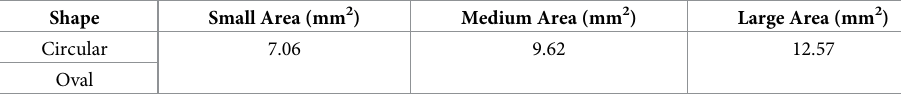
Table 1. Areas of the small, medium and large side-holes. Shape